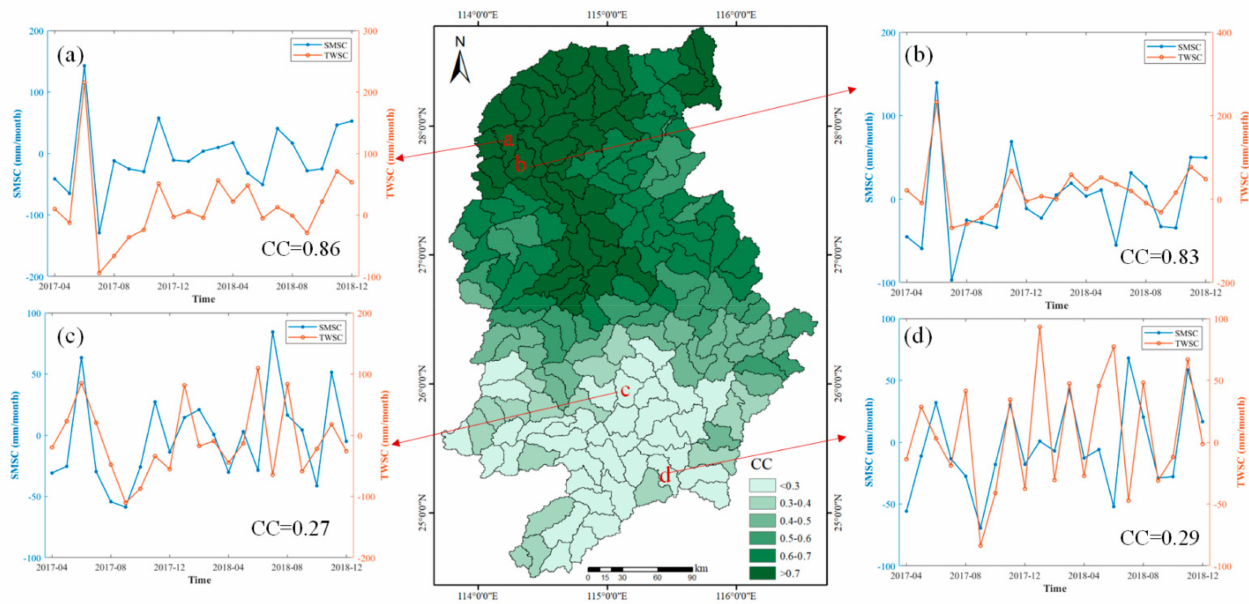
Figure 12. The spatial distribution of the CC between TWSC and SMSC ( a , b ) time series of two sub-basins with high CC, ( c , d ) time series of two sub-basins with low